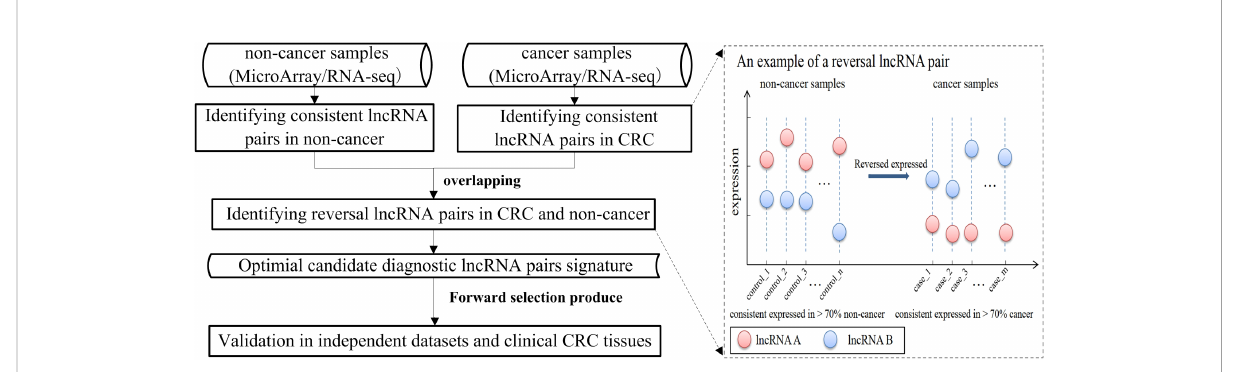
FIGURE 1 The work fl ow of identifying candidate diagnostic biomarker of colorectal cancer